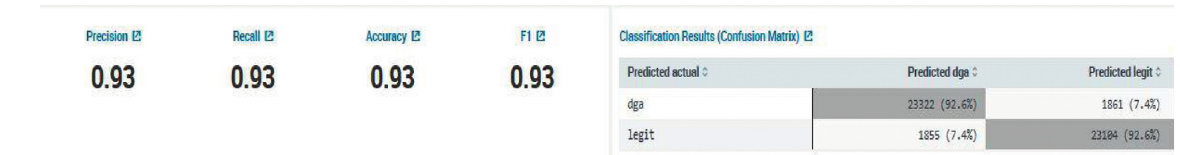
Figure 9: Evaluation of a stochastic forest model without using the principal component analysis feature.